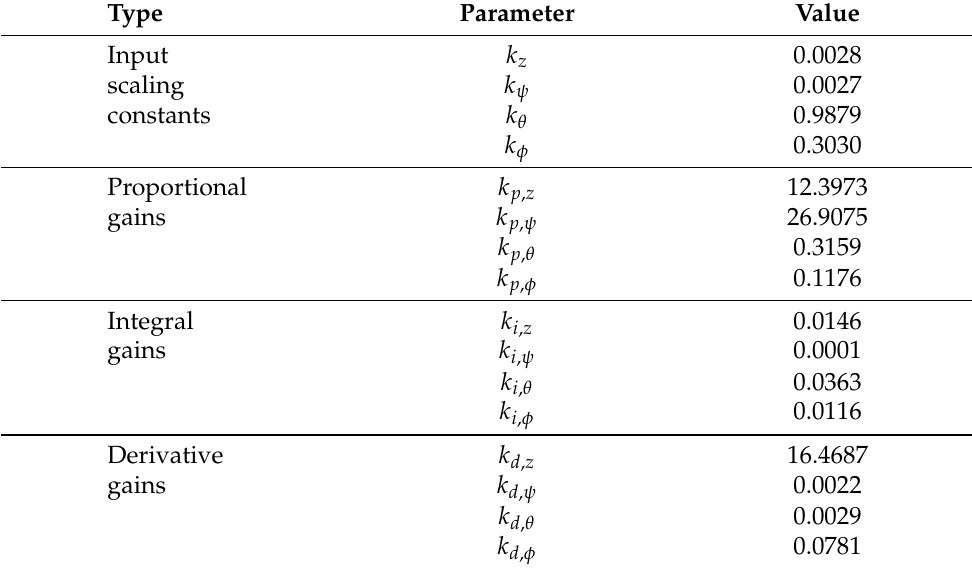
Table 2. Optimized teleoperation